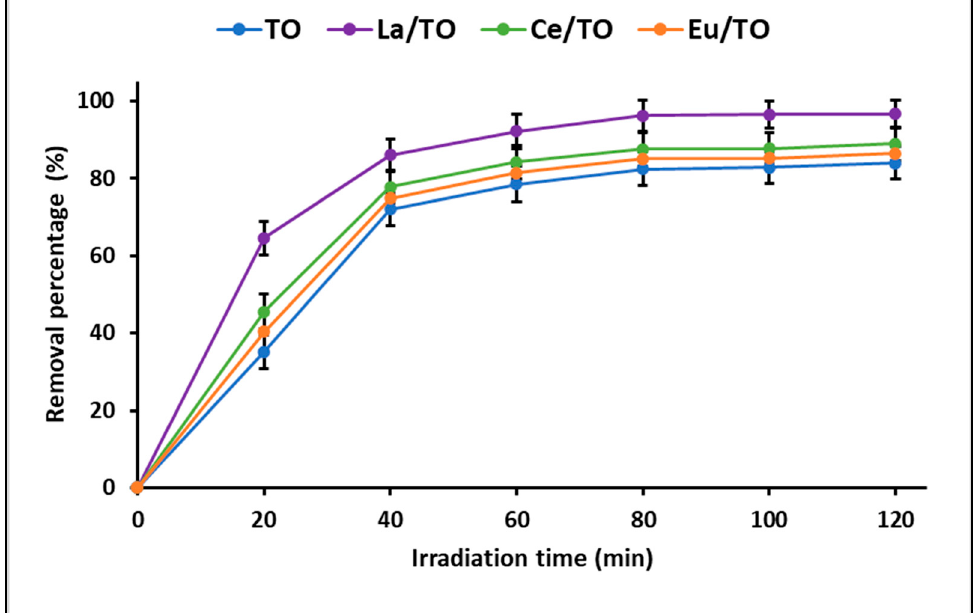
Figure 11. Photocatalytic cyanide degradation by nanoparticles.